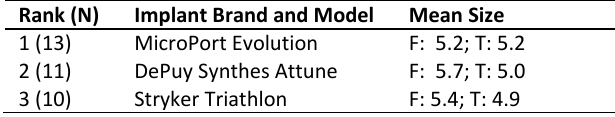
Table IIa. The three most utilized metallic knee prostheses used during the study period. Note, femoral (F) and tibial (T) components were matched in all patients.